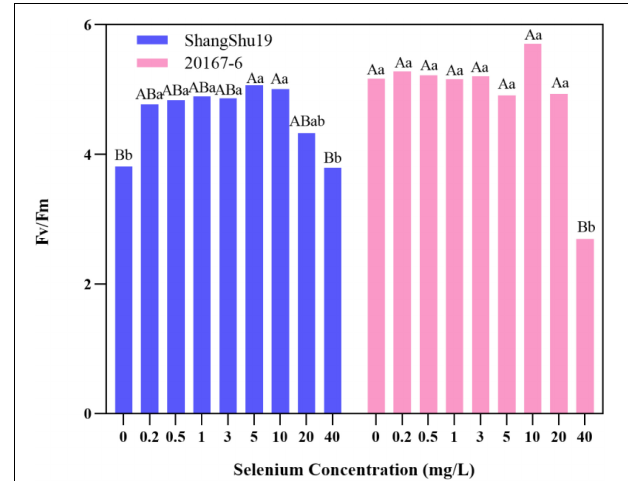
FIGURE 5 | The effect of different selenium concentrations on the root length of sweet potato. The root length of sweet potato is 0 cm at the concentration of 20 and 40 mg/L selenium. Different lowercase letters in the same category indicated that there were significant differences between Se treatments (Sig < 0.05); Different capital letters in the same category indicated that there were significant differences between Se treatments (Sig < 0.01).